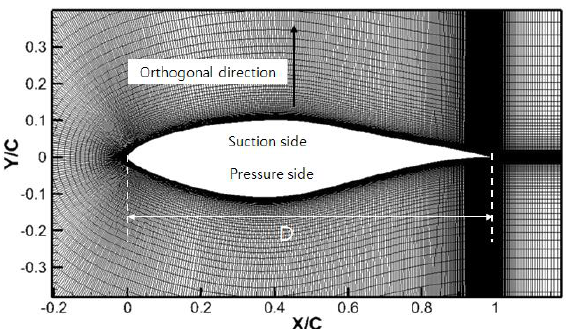
Figure 4. Close-up view of the mesh in the vicinity of the airfoil.